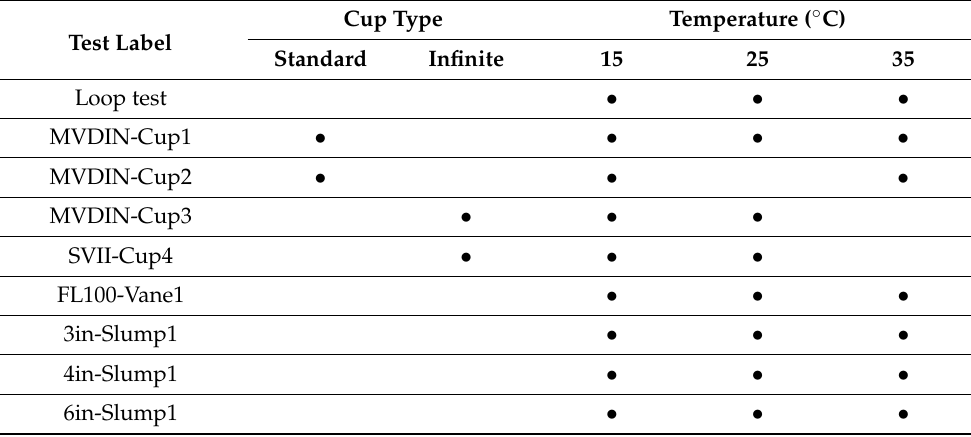
Table 4. Mine-B sample data (bullet represents measurement technique